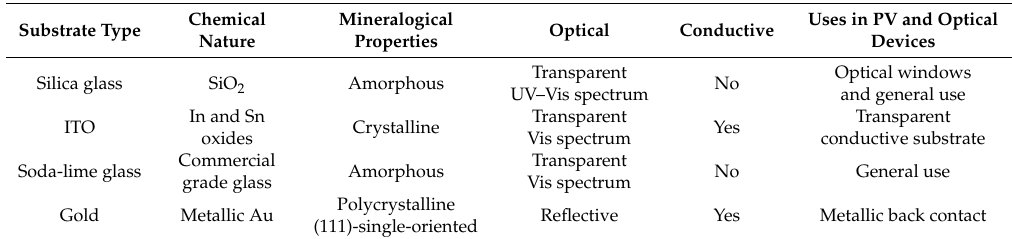
Table 1. Types of substrates used in this research. ITO, indium tin oxide; UV–Vis, ultraviolet–visible light; PV,